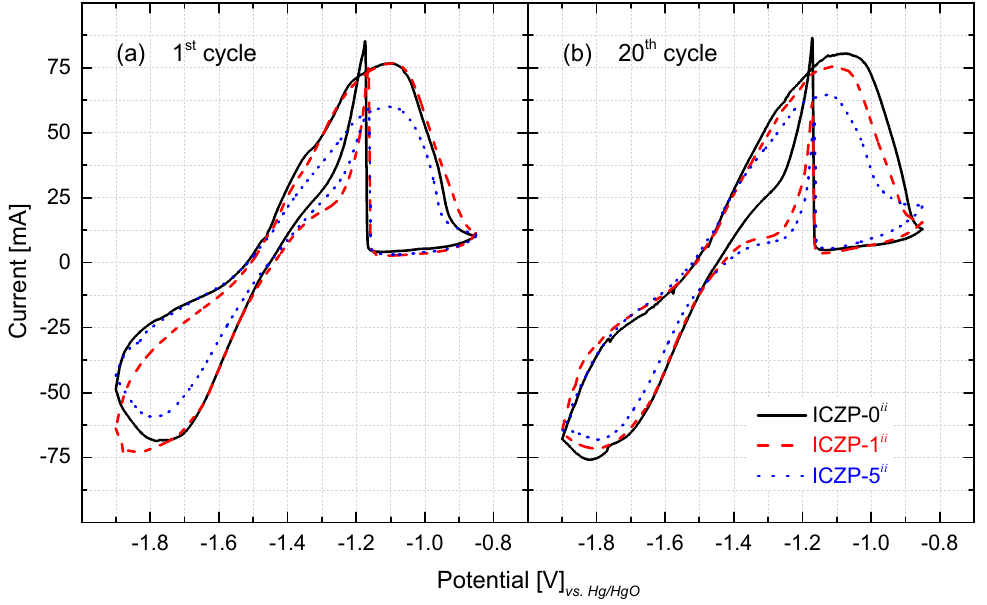
Figure 4. Cyclic voltammetric characteristics at ( a ) the 1st and ( b ) 20th cycle of uncoated (ICZP-0) and coated (ICZP-1 and ICZP-5) zinc particles in modified ( ii : 4s-2) aqueous alkaline electrolytes. Scan rate: 10 mV s − 1 .